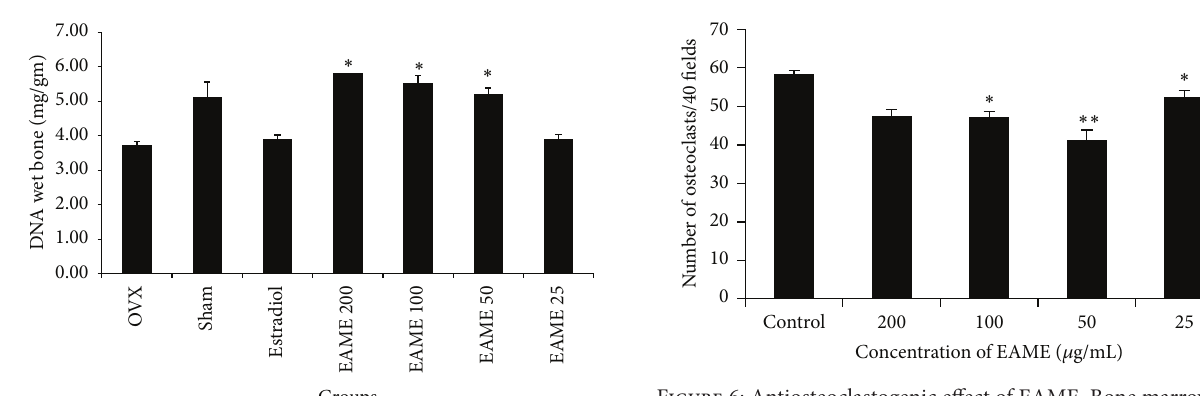
Figure 6: Antiosteoclastogenic effect of EAME. Bone marrow cells from 4–6wk old Swiss mice were incubated on coverslips in 35 mm dish (1 × 10 7 cells/mL) in the presence of M-CSF (30 ng/mL) and RANKL (30 ng/mL) with various concentrations of EAME (25 to 200 𝜇 g/mL). After 7d, cells were fixed and stained for TRAP, and the number of TRAP-positive MNC per well was scored. ∗ 𝑃 < 0.01 , ∗∗ 𝑃 < 0.001 when compared to control, ( 𝑛 = 3